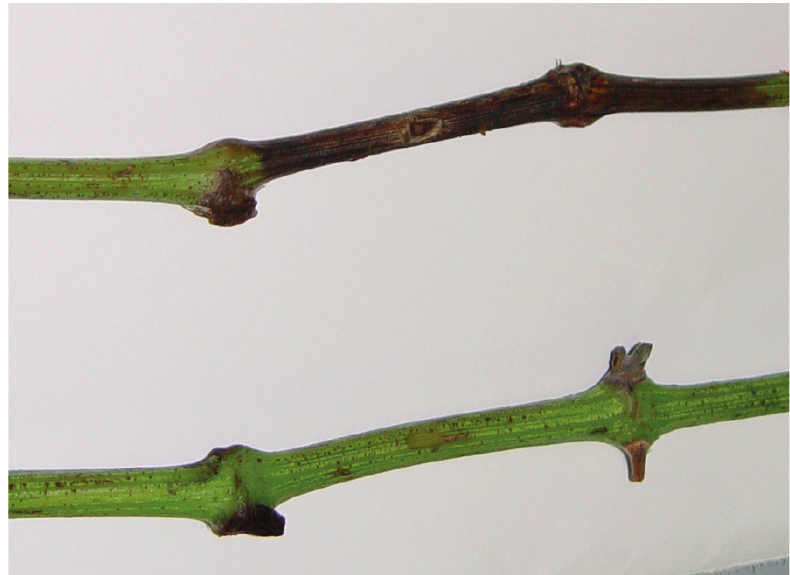
Figure 2. Grapevine shoot showing dark-brown lesion 12 days after inoculation with Neofusicoccum australe (top). Asymptomatic control shoot